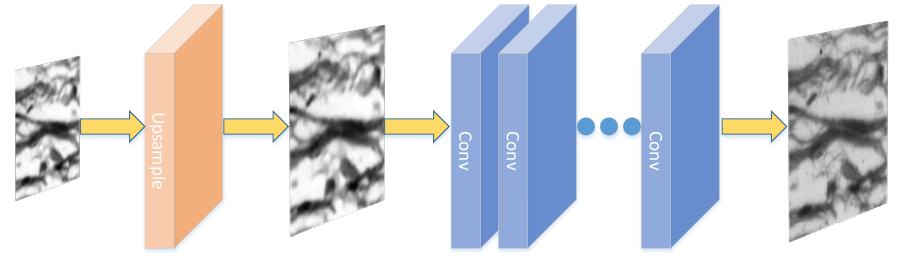
Figure 6. Pre-upsampling reconstruction module.